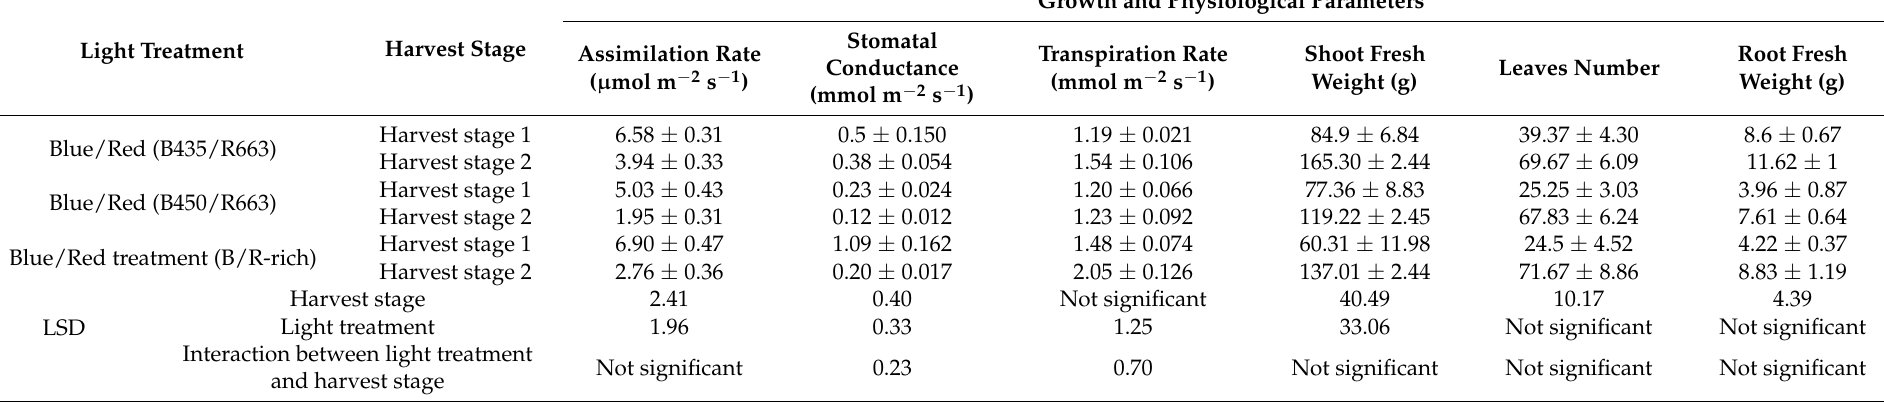
Table 1. The effects of high light intensity of different LED treatments on A: Assimilation rate (for harvest stage ( p ≤ 0.001), for light treatment ( p = 0.003) for interaction between light treatments and harvest stage ( p = 0.605)). B: Stomatal conductance (for harvest stage ( p ≤ 0.001), for light treatments ( p ≤ 0.001) and for interaction between light treatments and harvest stage ( p ≤ 0.001)). C: transpiration rate LSD for harvest stage ( p = 0.06) for treatments ( p = 0.066), and for interaction light treatments and harvest stage ( p = 0.001). D: Shoot fresh weight (g) (for harvest stages ( p ≤ 0.001), for treatment ( p = 0.003) and for interaction between harvest stage and light treatments ( p = 0.08)). E: Root fresh weight (g) for harvest ( p ≤ 0.001) for light treatments ( p = 0.083) and interaction ( p = 0.31). F: Leaves number (for harvest stage ( p ≤ 0.001), for light treatment ( p = 0.199) and for interaction between harvest stage and light treatments ( p =